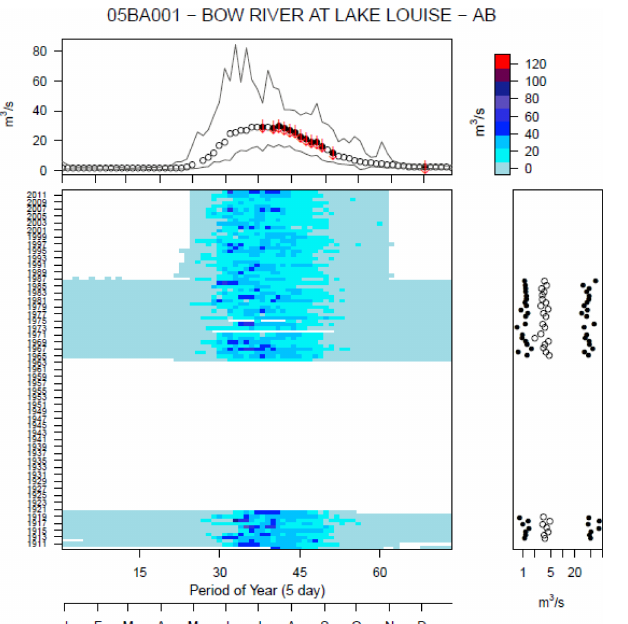
Figure 3. Plot of observed flows in the 05BA001 Bow River at Lake Louise, Alberta, a natural flow station. The main panel shows the 5d periods of the year against the years of record. White space indicates missing observations and the colours are scaled according to the bar in the upper right corner. The upper panel shows the maximum, me- dian and minimum flow for each of the 5d periods and red (blue) arrows indicate statistically significant decreases (increases) using Mann–Kendall τ at p ≤ 0 . 05. The panel on the right shows the an- nual minima, median (open circle), and maxima; statistically signif- icant decreasing (increasing) trends (Mann–Kendall τ a p ≤ 0 . 05) are indicated by red (blue).